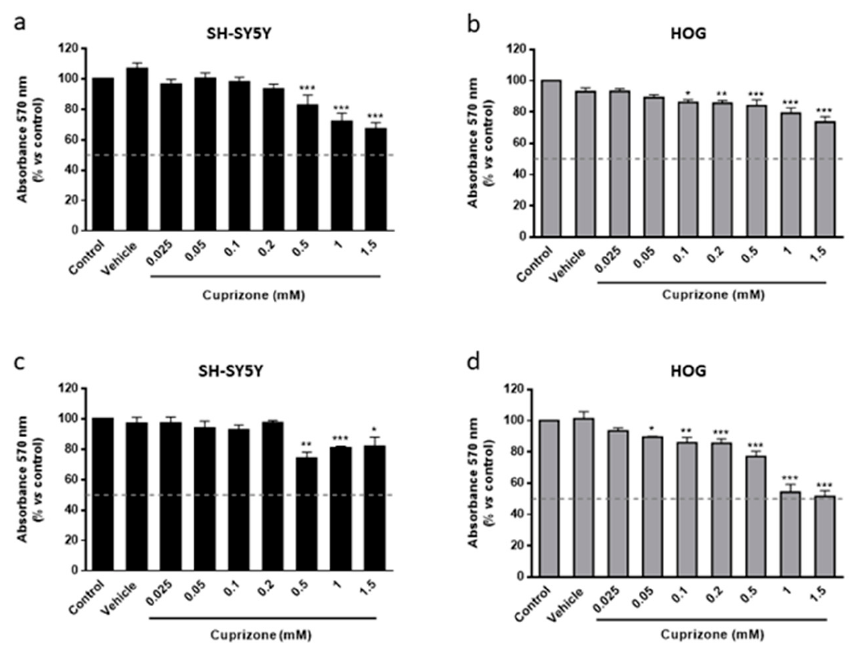
Figure 1. MTT reduction assay in SH-SY5Y ( a , c ) and HOG ( b , d ) cells treated with increasing con- centrations of CPZ (0.025–1.5 mM) for 24 ( a , b ) and 48 h ( c , d ). Cell damage is represented as the percentage of MTT reduction versus control. Data are the mean ± S.E.M of five independent experi- ments. Significant differences were analyzed by a one-way ANOVA followed by post-hoc Tukey’s test. * p < 0.05, ** p < 0.01, *** p < 0.001 compared to control.